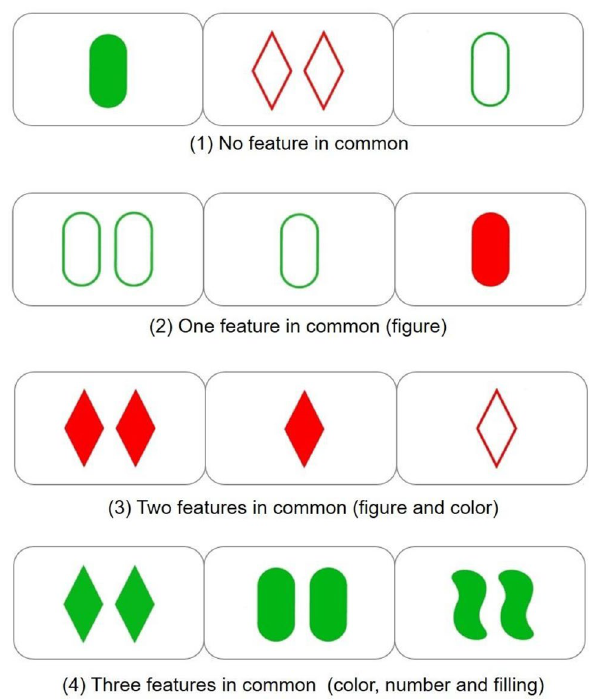
Figure 1. Example of items of SET in both